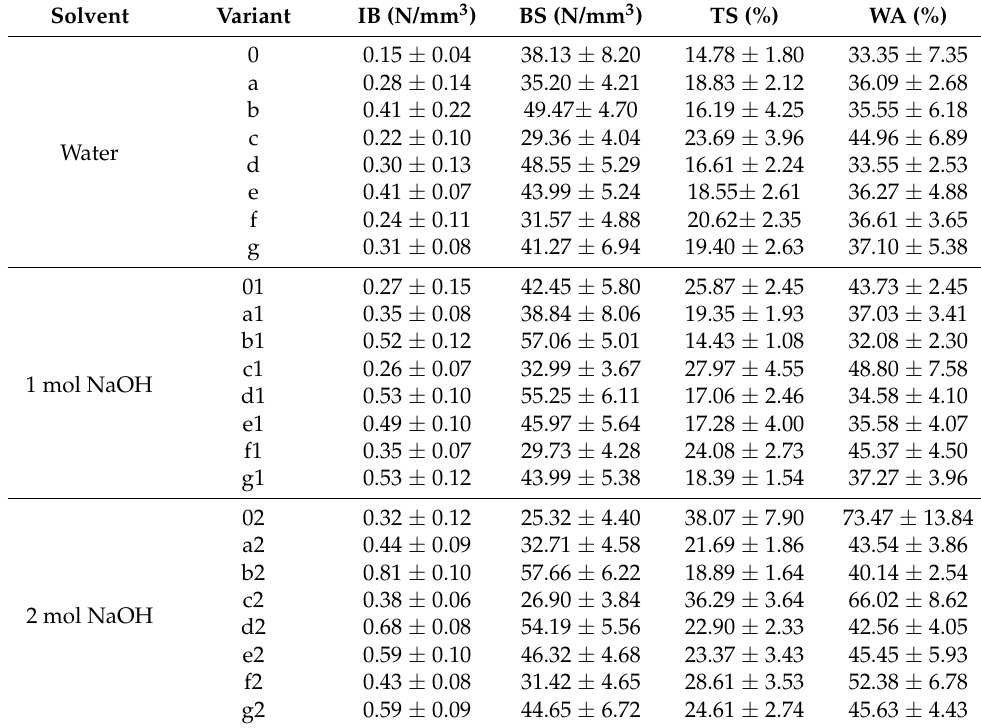
Table 3. Overview of the mechanical and dimensional properties of MDFs bonded with canola meal-based